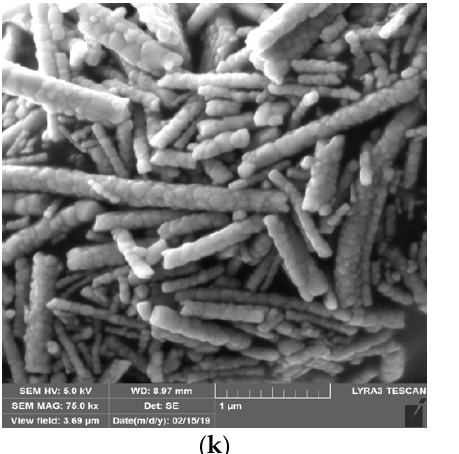
Figure 3. SEM images of fiber samples with low, medium, and high concentrations under different calcination profiles. ( a ) Low-as-spun, ( b ) Low-R2400-0h, ( c ) Low-R600-0h, ( d ) Low-R600-24h, ( e ) Medium-as-spun, ( f ) Medium-R2400-0h, ( g ) Medium-R600-0h, ( h ) Medium-R600-24h, ( i ) High-as-spun, ( j ) High-R2400-0h, ( k) High-R600-0h, and ( l ) High-R600-24h.